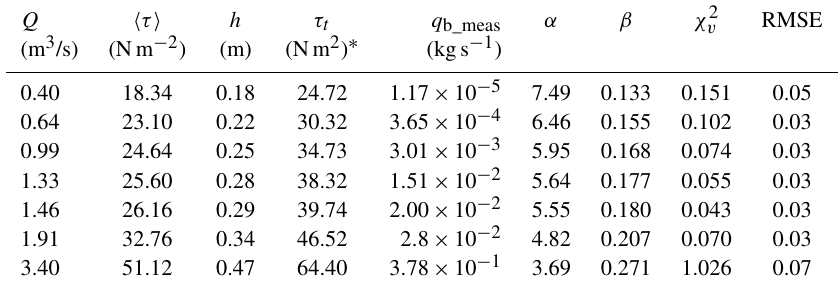
Table 1. Summary of model shear stress distributions including reach-averaged shear stress ( (cid:104) τ (cid:105) ), mean modeled water depth ( h ), and total shear stress ( τ t = ρghS b ); measured bed load transport rate ( q b_meas ) (Milhous, 1973), gamma fit parameters ( α and β ), and goodness of fit: reduced chi-square ( χ 2 v ) and root mean square error (RMSE) between the observed distribution of shear stress and the gamma fit predicted distribution.